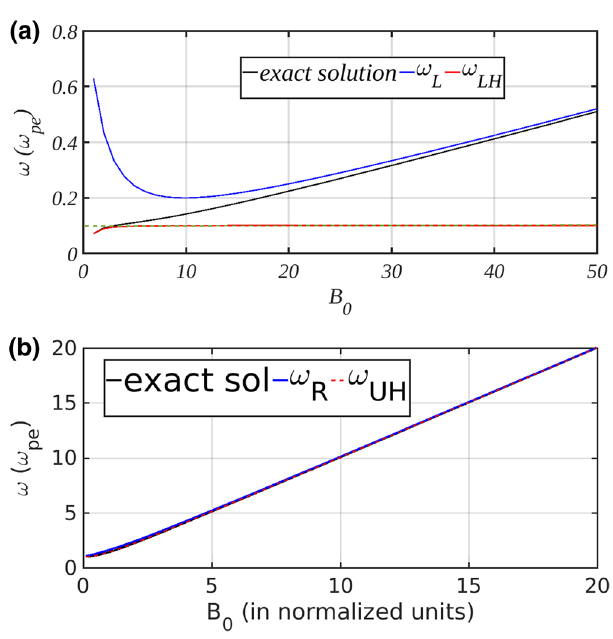
Figure 4. ( A ) Comparison of lower exact solution for ω (Eq. 6) with cut off frequency and analytical expression of LH as function of B 0 . As one can observe that at lower magnetic field value, there’s gap between values of ω L and ω LH but at high value of magnetic field where exact solution of ω will play a role, it matches with ω L ; signifying the shrink of stop band. Green dash-line indicates the ω pi position in the plot. ( B ) Comparison of upper exact solution for ω with cut off frequency and analytical expression of UH as function of B 0 . As one can observe that at lower magnetic field value there’s gap between values of ω R and ω UH but at high value of magnetic field where exact solution of ω will play a role it matches with ω R indicative to the vanishing of stop